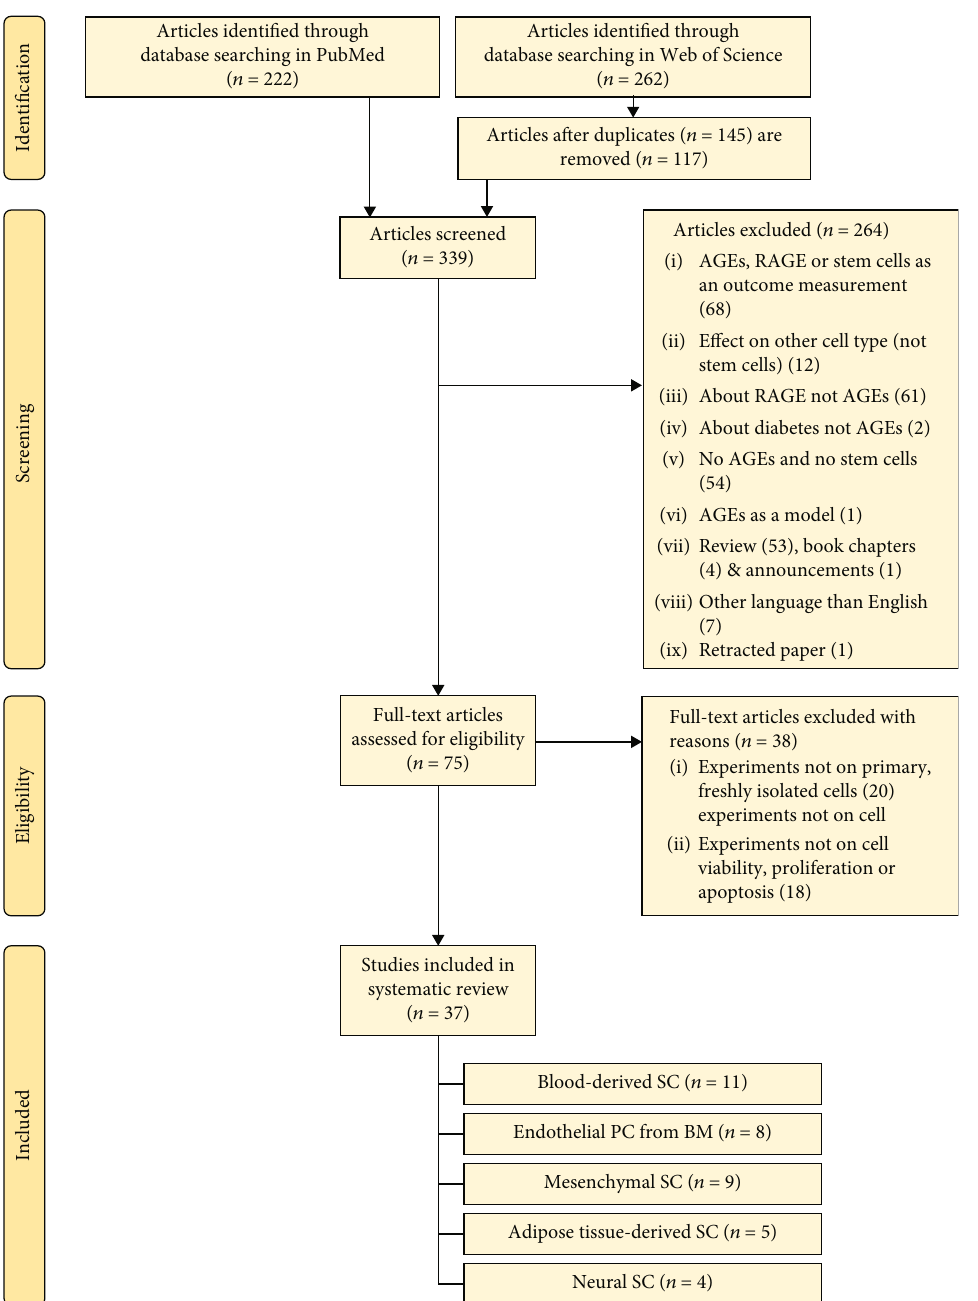
Figure 1: Flowchart summary of the search and selection of the included articles. AGEs: advanced glycation end-products; RAGE: receptor for AGEs; PC: progenitor cells; SC: stem cells; BM: bone